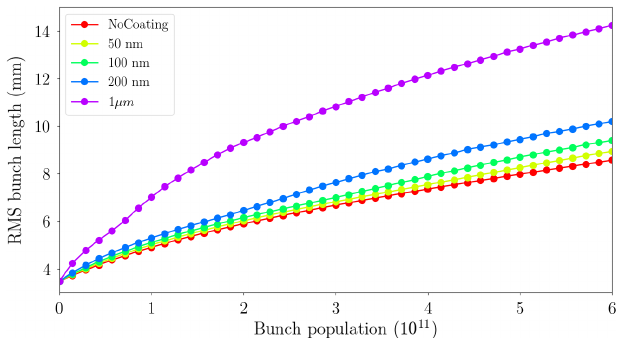
FIG. 6. Bunch length as a function of the bunch intensity obtained from numerical simulations in the case of no coating and with different thicknesses of coating B. The other machine parameters are those of Table I with the lowest machine energy.